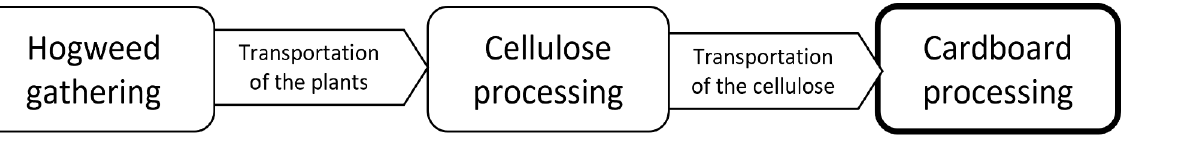
Figure 6. Business model ‘ installations with pretreatment’. Bold contour highlights processes per- formed by other organizations (contractors, consumers, etc).